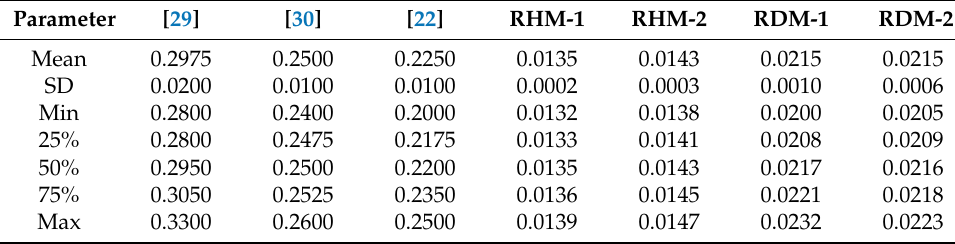
Table 20. Validation in probabilistic